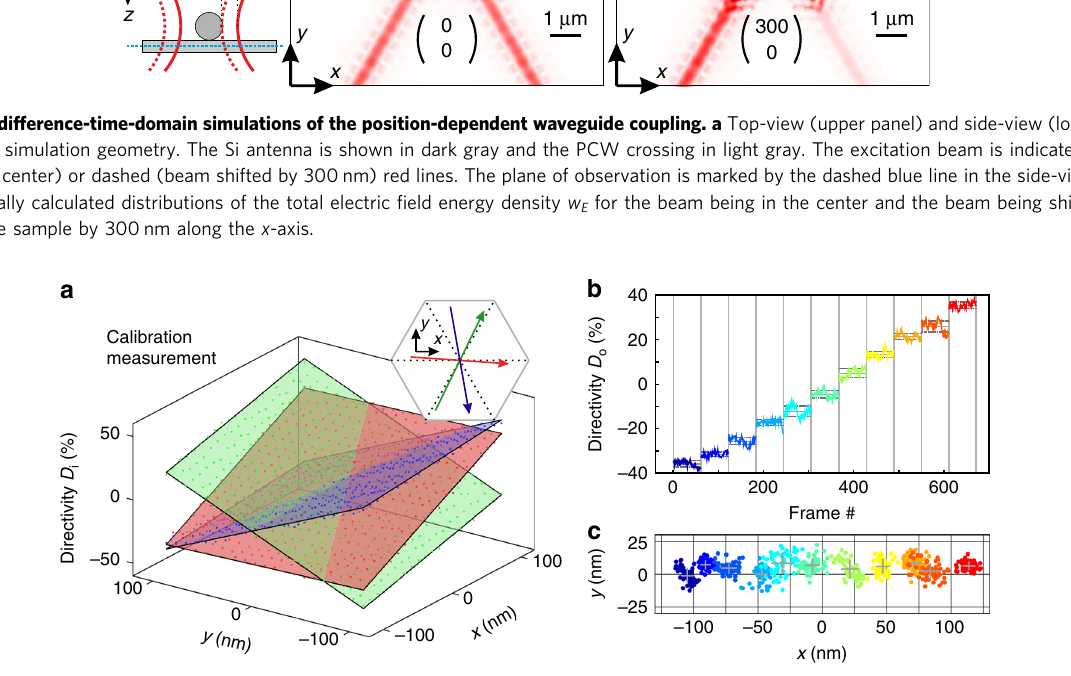
Fig. 5 Calibration measurement and experimental localization results. a The directivity parameters D 0 (red dots), D 60 (green dots), and D 120 (blue dots) are plotted against the corresponding positions set by the piezo stage. The semi-transparent color-matching planes correspond to two-dimensional linear equations that are fi tted to the experimental data. The gradient vectors of the individual planes are plotted as arrows in the hexagonal inset, while the actual orientations of the waveguides are indicated as black dotted lines. b The directivity D 0 is plotted for a line scan along the x -axis with a step size of 25 nm. For each position (denoted by one single color) set by the piezo stage, 61 camera frames are captured and the directivity parameters are determined. c For the same scan, the two-dimensional position is calculated using the calibration